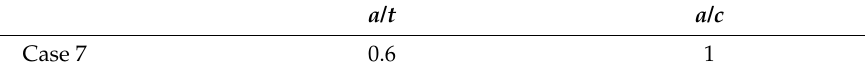
Figure 9. Schematics of pipe with circumferential semi-elliptical inner surface crack. Table 5. Shape variables of the cracks.